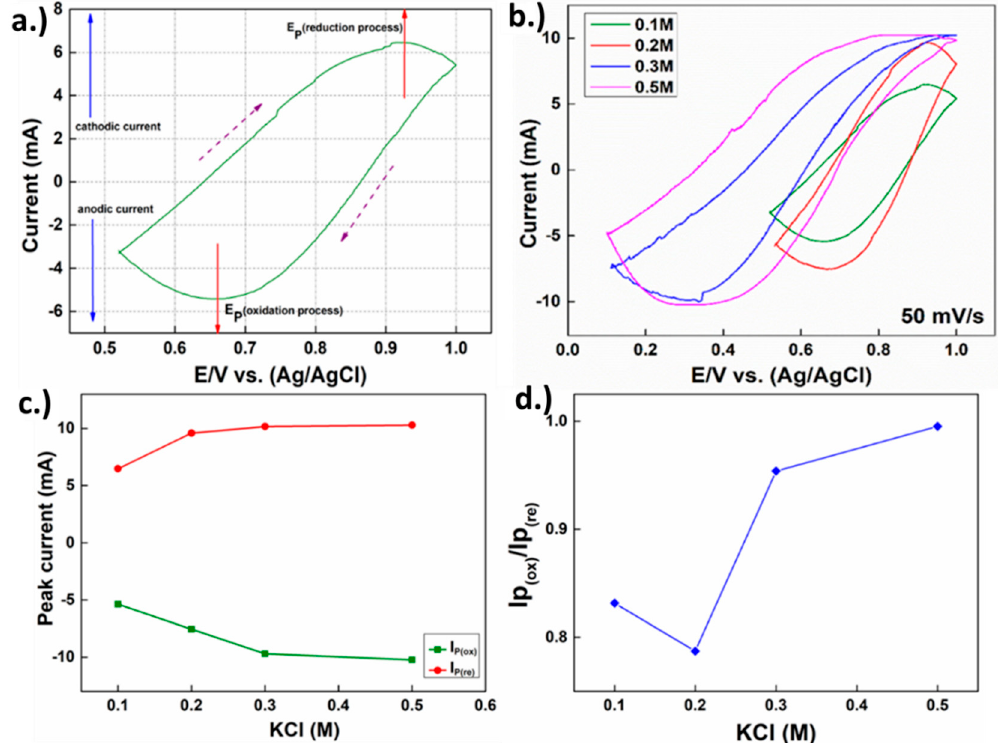
Figure 3. Cyclic voltammetry (CV) measurement of ( a ) ZnO with 0.1 M of KCl; and ( b ) ZnO growth dependence of 0.1 M – 0.5 M for KCl concentration. The effect of KCl concentration in cyclic voltammetry to growth ZnO; ( c ) peak oxidation and reduction in each KCl concentration; ( d ) ratio of redox reaction vs KCl concentration ranging from 0.1 M to 0.5 M.